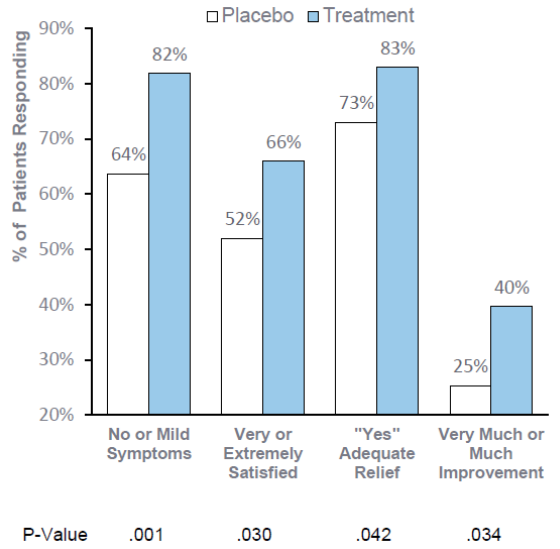
Figure 3. Global Patient Assessments. Patients’ global assessments were evaluated 30 days after treatment (day 61) and were based on a patient questionnaire.